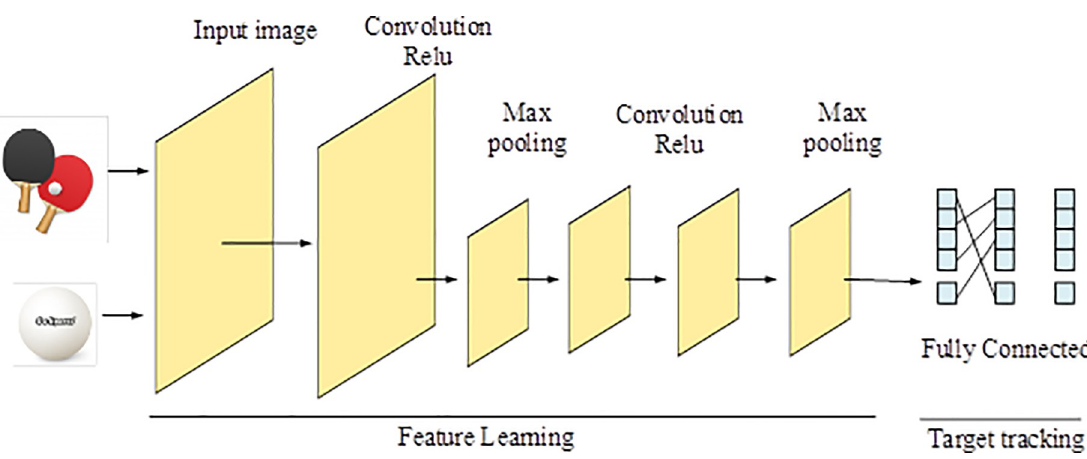
Fig 3. DDPG algorithm based on deep reinforcement